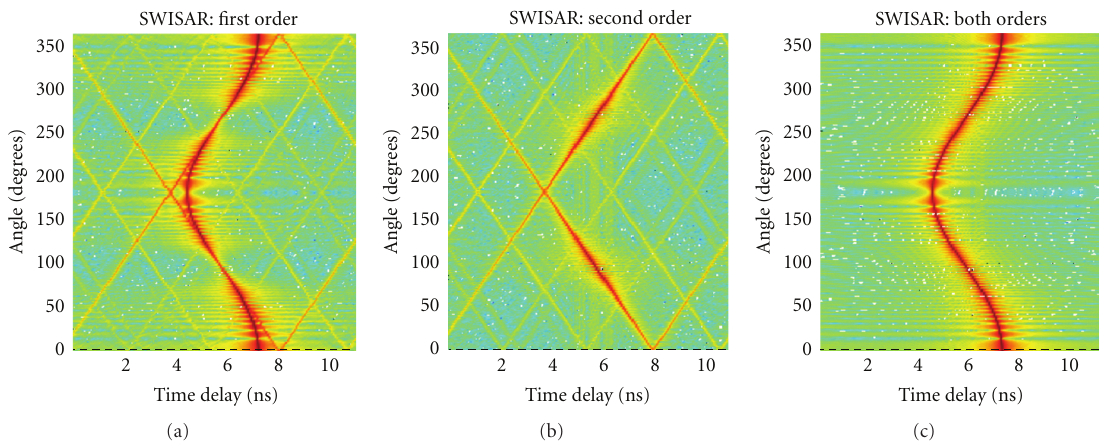
of first-order ( K φ ≤ (cid:27) K φ ) φ , k f of full k φ Fourier φ , k f